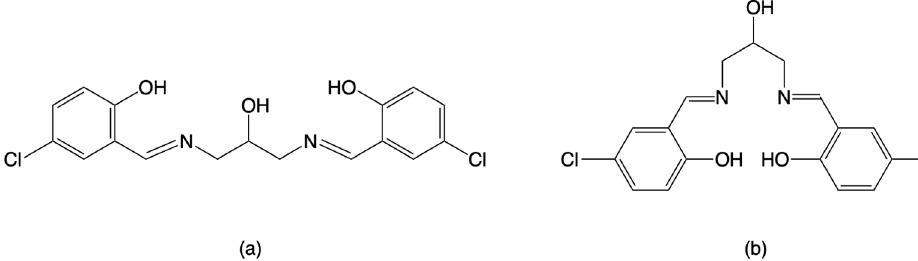
Figure 1. Schiff-base ligand 1,3-bis(5-chlorosalicylideneamino)-2-propanol as ( a ) pentadentate dinu- cleating ligand and ( b ) tetradentate mononucleating ligand.